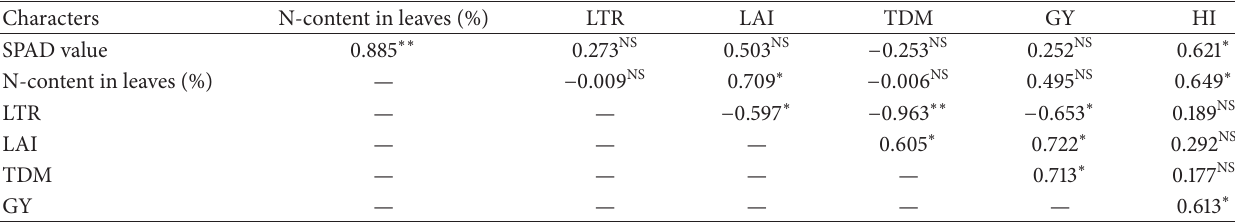
Table 4: Interrelationship among the different plant characters of maize